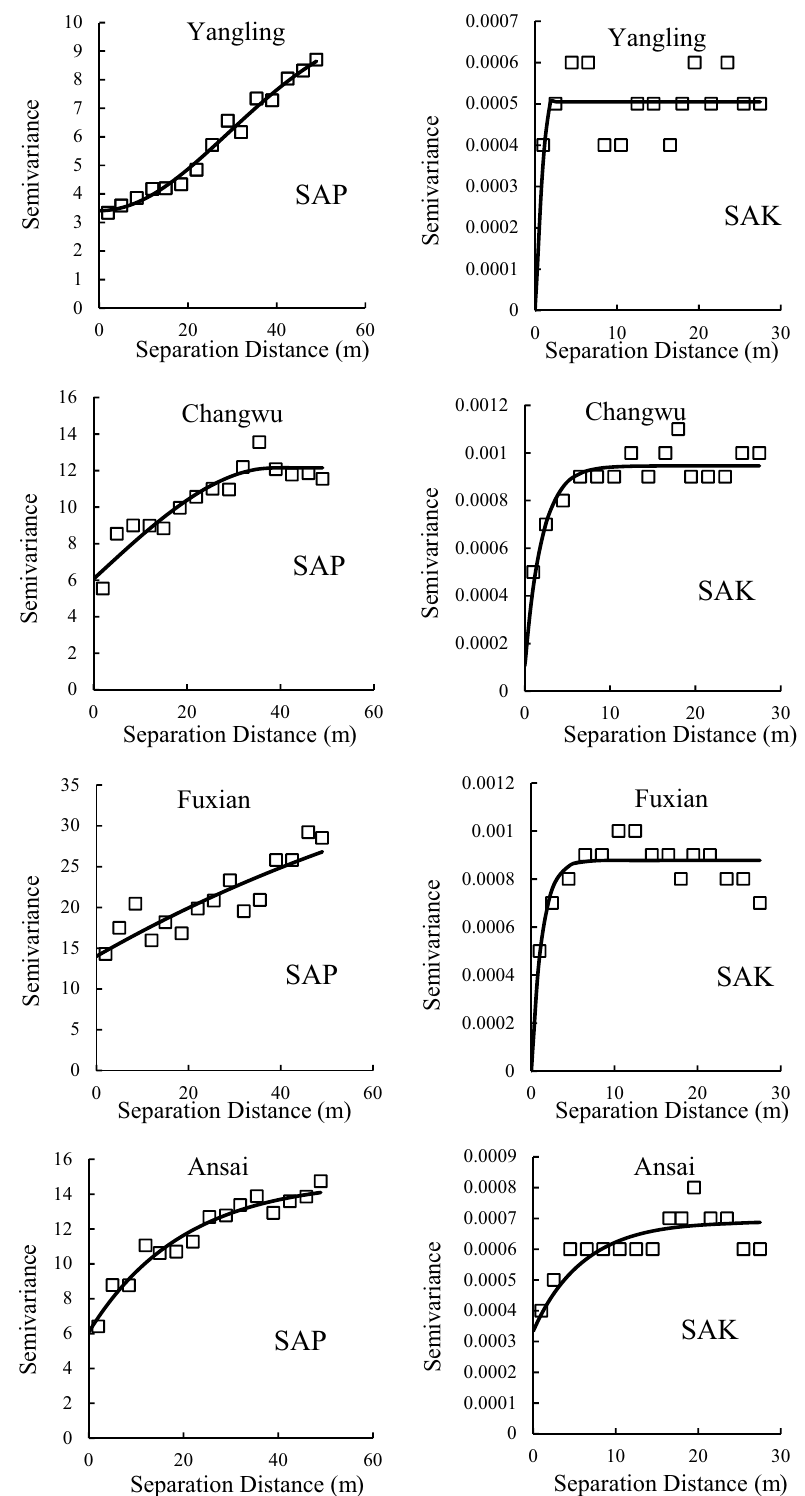
Figure 3. Semivariograms of soil available phosphorus (SAP) and soil available potassium for the sampling sites; the data extracted from GS + and mapped by Excel https ://www.micro soft.com/zh-cn/micro soft-365/excel